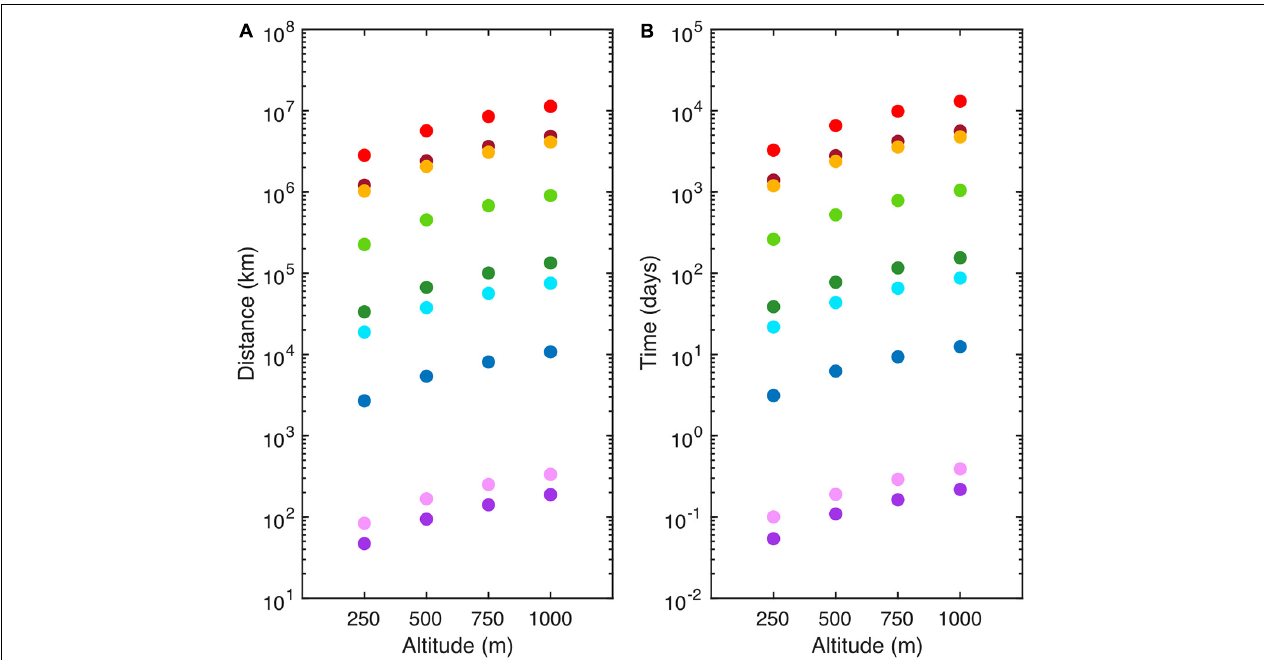
FIGURE 2 | Atmospheric transportation of representative marine microorganisms and Coronavirus (SARS-CoV-2) (A) Potential distance traveled (km) and (B) residence time (days) of SARS-CoV-2 (red), Emiliania huxleyi virus (maroon), SAR11 (orange), Prochlorococcus (light green), Synechococcus (dark green), Micromonas pusilla (light blue), Emiliania huxleyi (dark blue), Thalassiosira weissflogii (light purple), and Dinophysis acuminata (dark purple). Values were determined using Stoke’s Law for aerosol particles released at specific altitudes (250–1,000 m) at the average tropospheric temperature (15 ◦ C) in a homogeneous atmosphere. Residence time was calculated using a representative average wind speed of 10 m s − 1 . Distance traveled and residence time should be considered the upper limit as these estimates do not account for loss processes such as wet